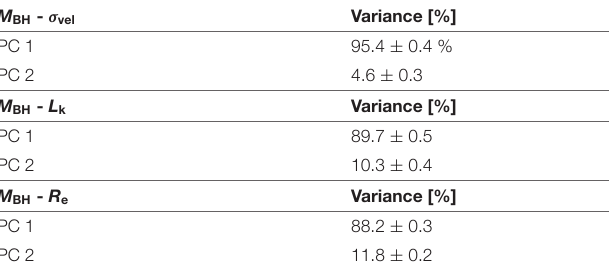
TABLE 1 | The variance percentages contained by the principal components resulting from our PCA on the three 2D-datasets, M BH - σ vel , M BH - L k and M BH - R e , are